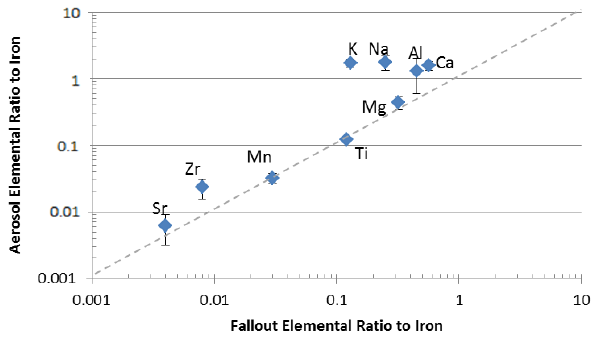
Fig. 6. Elemental ratio to iron in the aerosol sample collected at Figure 6. Elemental ratio to iron in the aerosol sample collected at CMN on May 18, 2010 vs. 2 CMN on 18 May 2010 vs. direct fallout collected on 16 May direct fallout collected on May 16 (GSV165-3) near the Eyjafjallajökull crater 3 (GSV165-3) near the Eyjafjallajökull crater (http://earthice.hi.is/ (http://earthice.hi.is/eyjafjallajokull_2010_chemical_composition). The dashed line indicates 4 eyjafjallajokull_2010_chemical_composition). The dashed line in- dicates equal ratio. Data refer to PIXE–PIGE equal ratio. Data refer to PIXE-PIGE analyses. 5